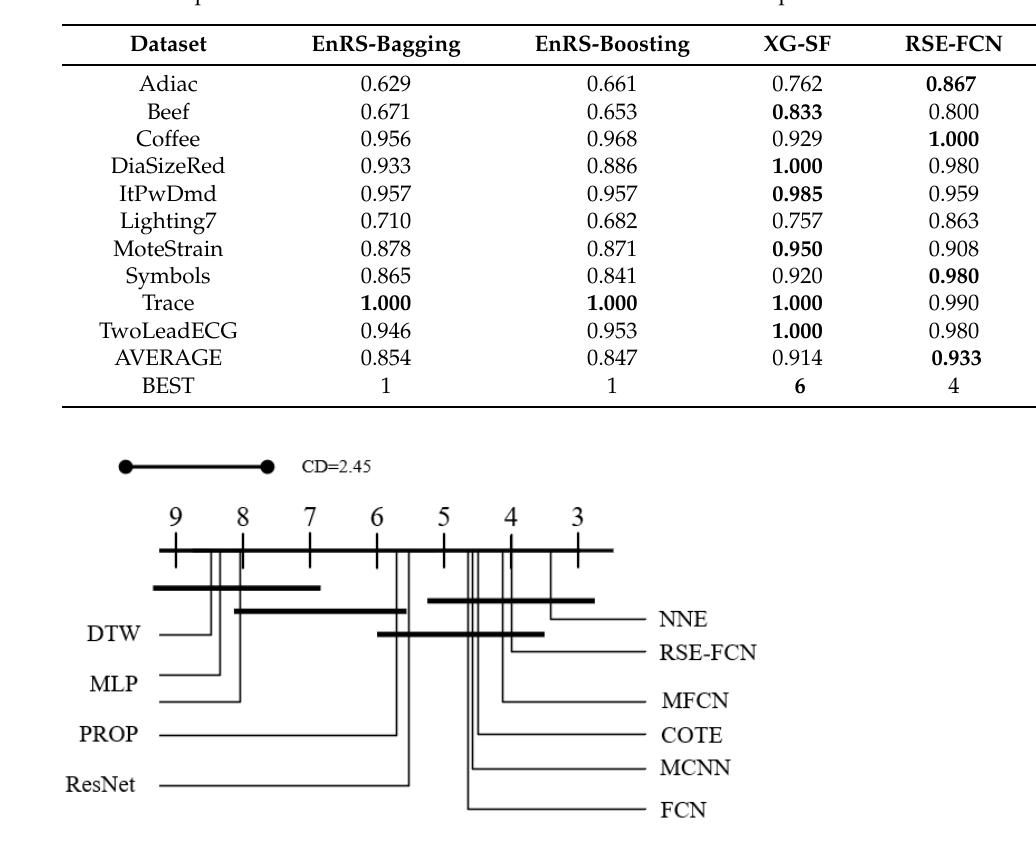
Table 3. Comparison on common datasets with the models based on shapelets information.